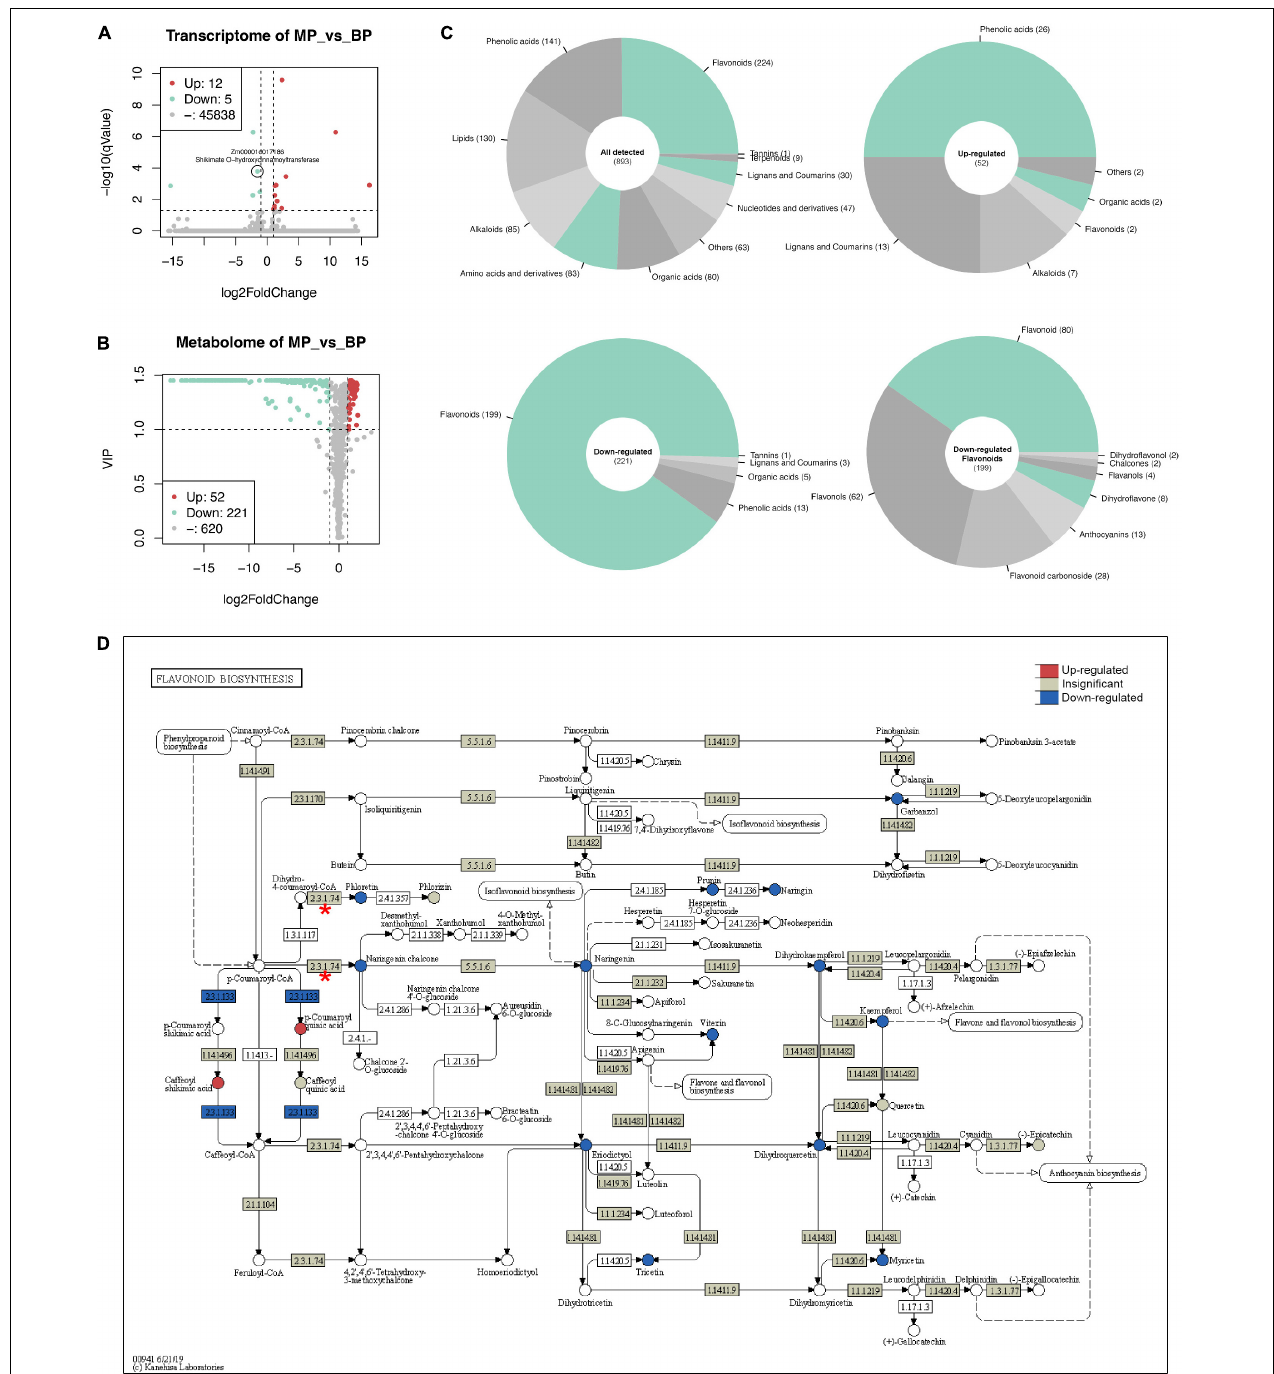
FIGURE 4 | Transcriptomic and metabolic changes in maize first sheath due to ZmC2-E183K mutation. RNA-seq and widely targeted metabolome were performed on the first sheaths of B73-type F2 progeny (BP) and those of mutant-type F2 progeny (MP). Seedlings were grown to three-leaf stage in a greenhouse. For each type of sample, multiple individuals were pooled together. RNA-seq was performed with two biological replicates, and metabolome with three biological replicates. (A) Volcano plot for RNA-seq. The cut-off for differentially expressed genes (DEGs) is | log2FoldChange| ≥ 1 and q -value ≤ 0.05. Zm00001d017186 (Shikimate O-hydroxycinnamoyltransferase) is labeled out as the only DEG related to flavonoid biosynthesis. (B) Volcano plot for metabolome results. The cut-off for differentially expressed metabolites is | log2FoldChange| ≥ 1 and VIP ≥ 1. (C) Classification of metabolites. Upper left, all detected metabolites; upper right, up-regulated metabolites; lower left, down-regulated metabolites; lower right, more detailed classification of down-regulated flavonoids. (D) View of gene expression and metabolite changes in flavonoid biosynthesis (kegg-zma00941). In the pathway, circle represents metabolites and box represents reactions and genes. 2.3.1.74 with red asterisk is ZmC2 involved reaction; 2.3.1.133 in blue color is Zm00001d017186 involved reaction.